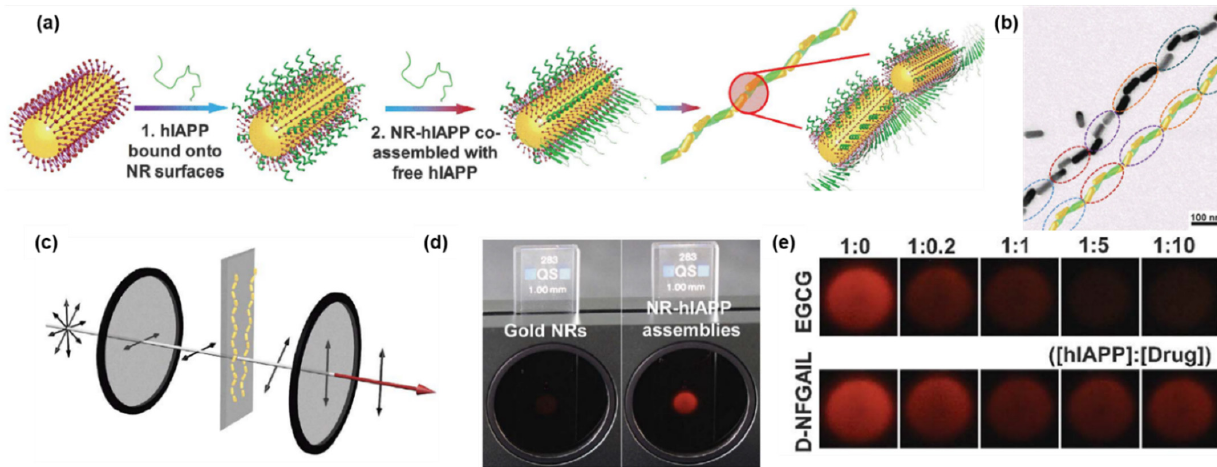
Figure 11. ( a ) Schematics of the assembly process of hIAPP monomers with NRs. ( b ) TEM image and reconstructed model of NR-hIAPP assemblies. ( c ) Schematics for cross-polarization optical cell. ( d ) Photographs of pure Au NRs and NR-hIAPP assemblies under cross-polarization conditions. ( e ) Photographs of the NR-hIAPP coincubated with two model drugs in different concentrations under cross-polarization conditions. Reprinted with permission from Ref. [29]. Copyright 2021 the Amer- ican Association for the Advancement of Science.